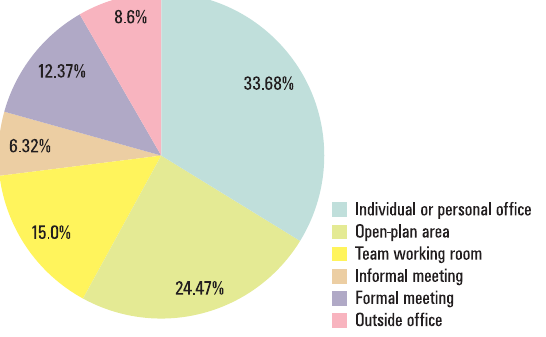
Figure 6. Time spending in different working Table 3. Mean rank for Kruskal Wallis test of working-time spent in different areas Working area